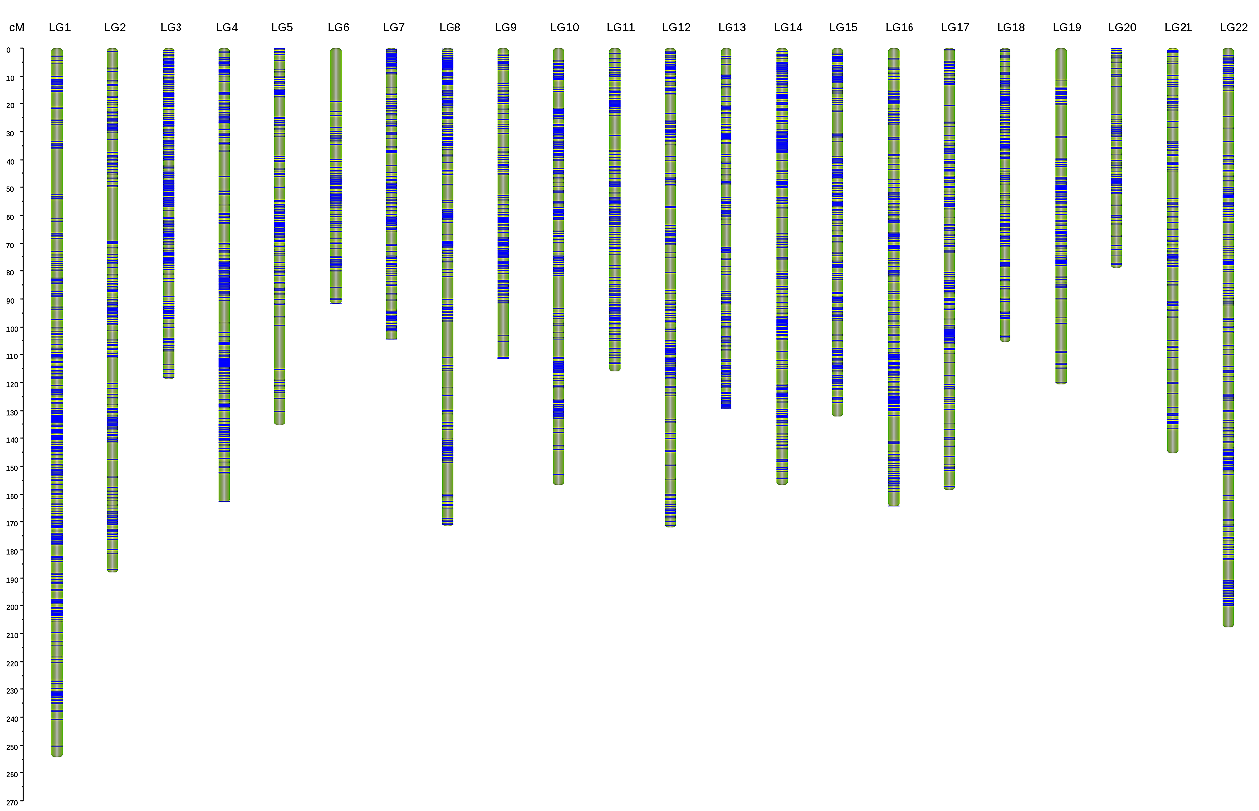
Figure 1. Consensus linkage map of Apostichopus japonicus . Blue bars represent SNPs. The scale on the left indicates the genetic distance in centimorgans (cM).